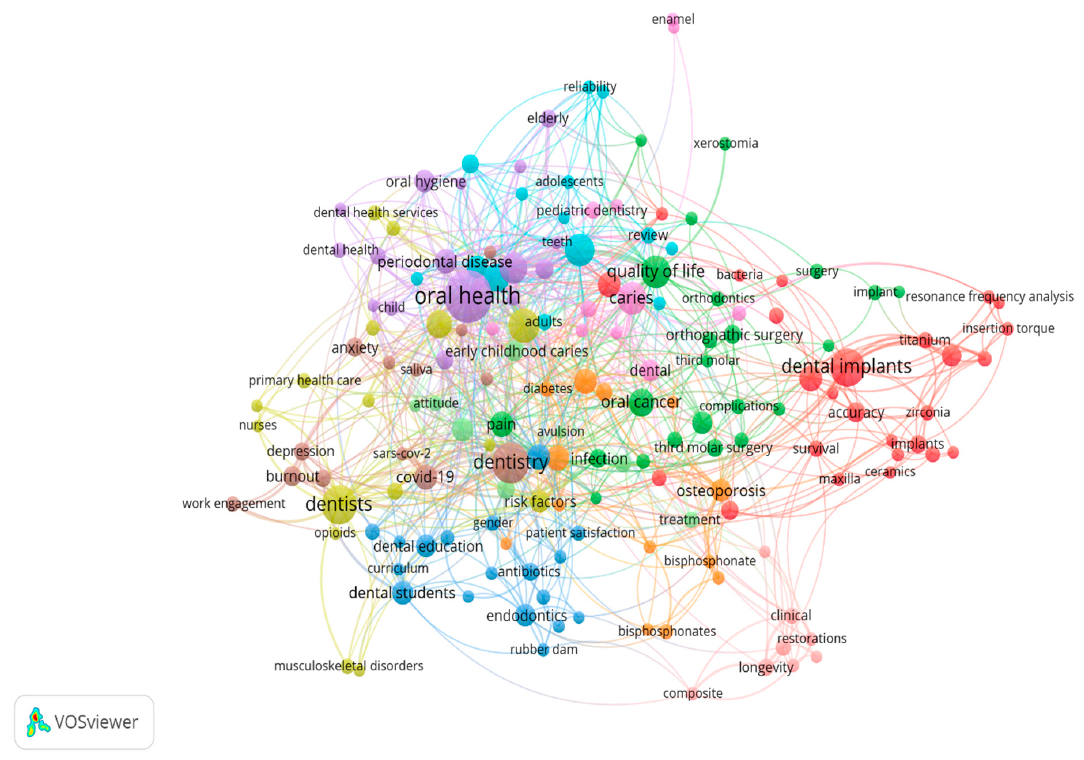
Figure 7. Network visualisation of author keywords.